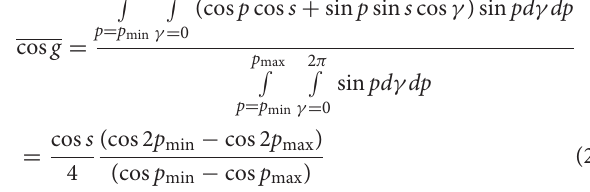
also varies (Jackson et al., 2000; Constable, 2007). In